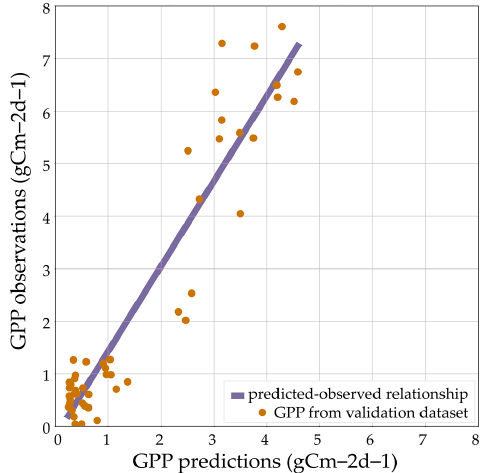
Figure 8. Scatter plot with fitted regression line showing the correlation between the predicted GPP MOD17 predictions ( x -axis) and the observed GPP values ( y -axis).